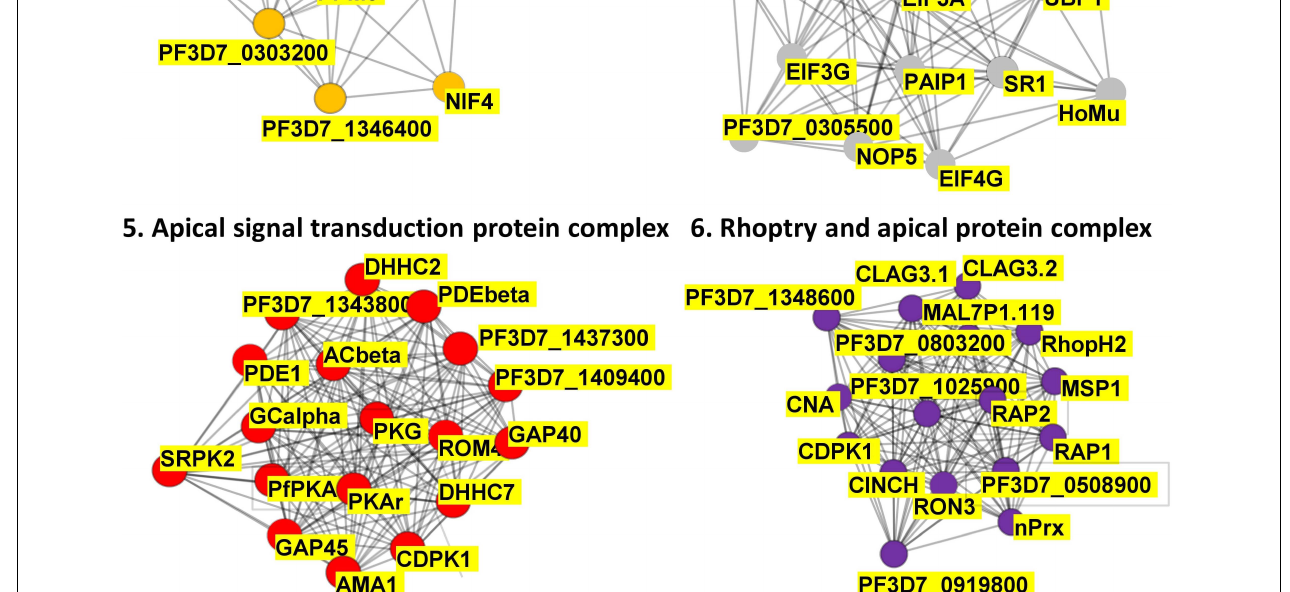
Frontiers in Microbiology |